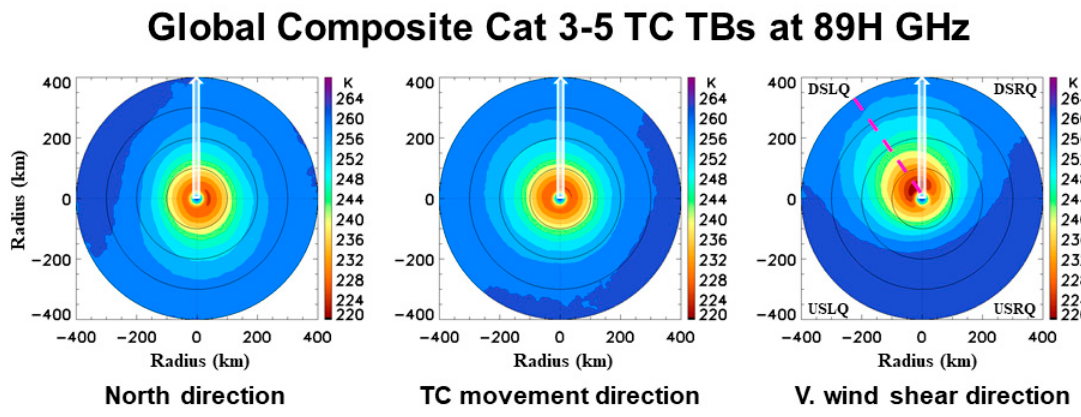
Figure 6. Climatology of major hurricanes at 89H GHz composited from global TCs in 1987–2012. Left, middle and right panel is for composition with direction of northward, TC movement and 200–850 hPa wind shear, respectively. White arrow is shown as direction of the composition method for each panel. The red dashed line in the right panel is for axis of the minimum TBs.